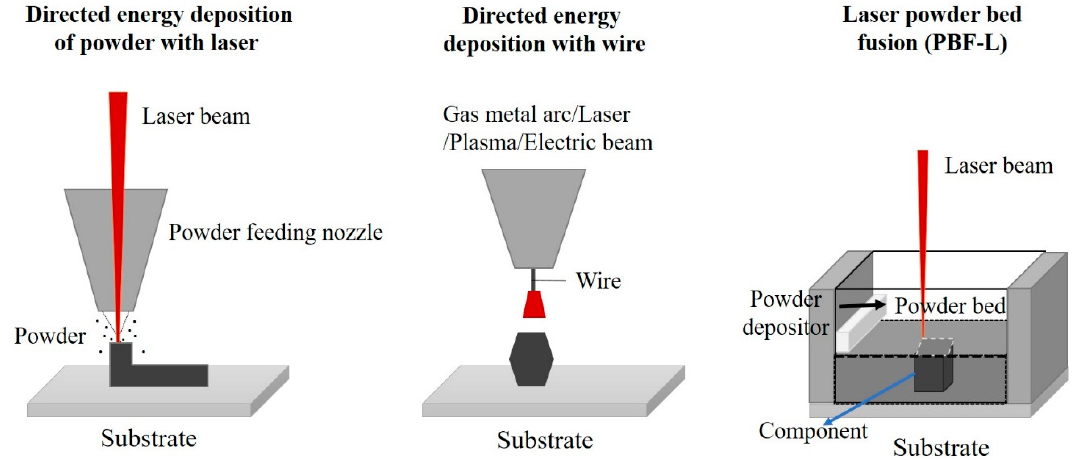
Figure 4. Schematics of main additive manufacturing processes .